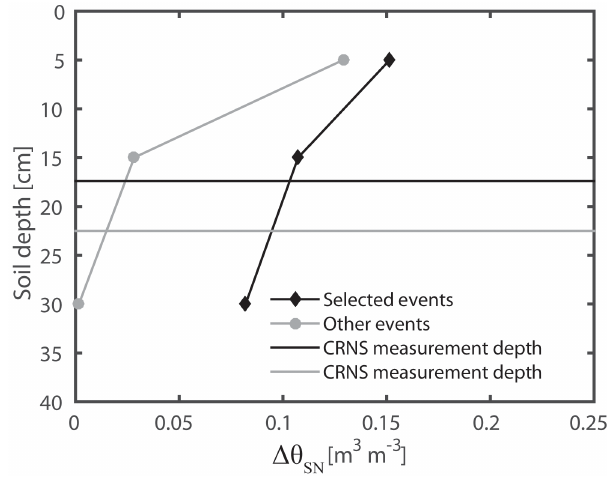
Figure 8. Change in soil moisture ( (cid:49)θ SN ) at depths of 5, 15, and 30cm at the JER for the five large events (selected events) and the remaining cases (other events). Horizontal lines are the time- averaged CRNS measurement depths averaged over selected events (black; standard deviation of 3.8cm) and other events (gray; stan- dard deviation of